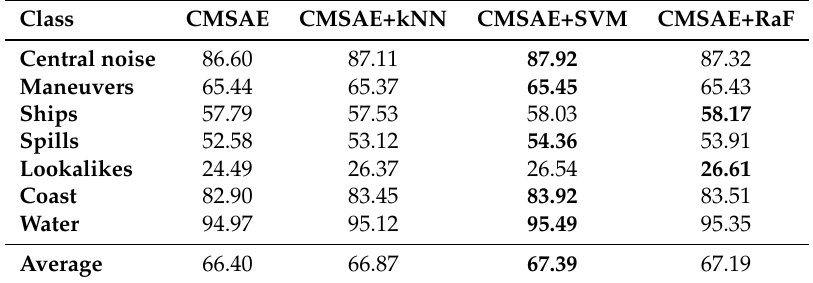
Table 4. Best results ( F 1 %) obtained by the different classifiers considered for the last stage of the algorithm. The best result obtained for each class is marked in bold.